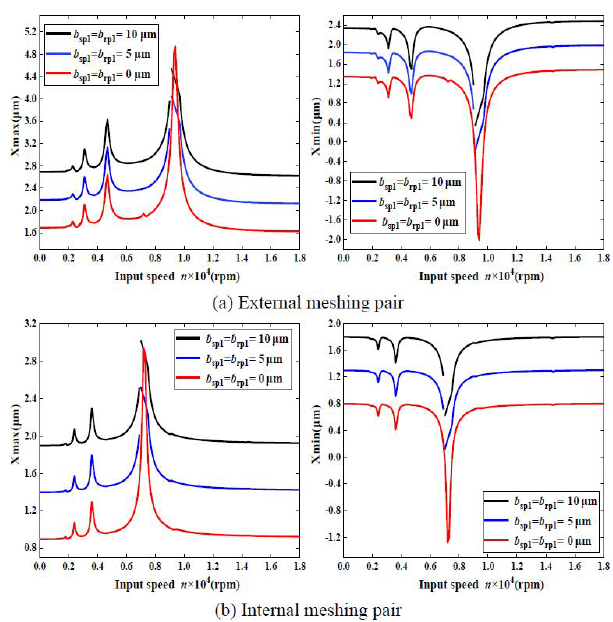
Figure 9. Effect of backlash on the vibration response curve.